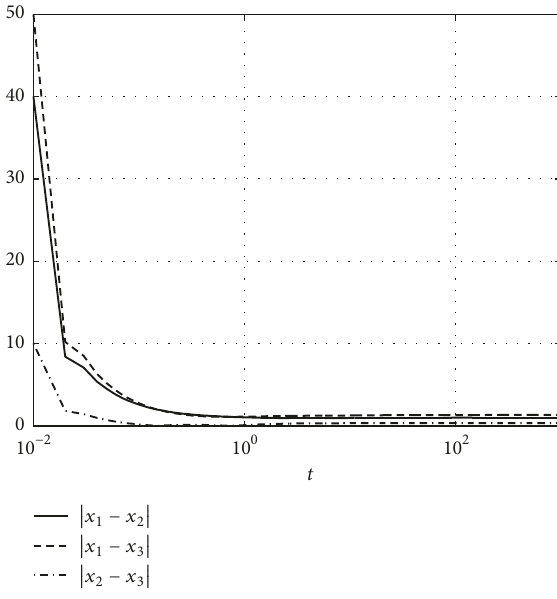
Figure 8: Linear case with perturbation, 𝑗 = 1 .